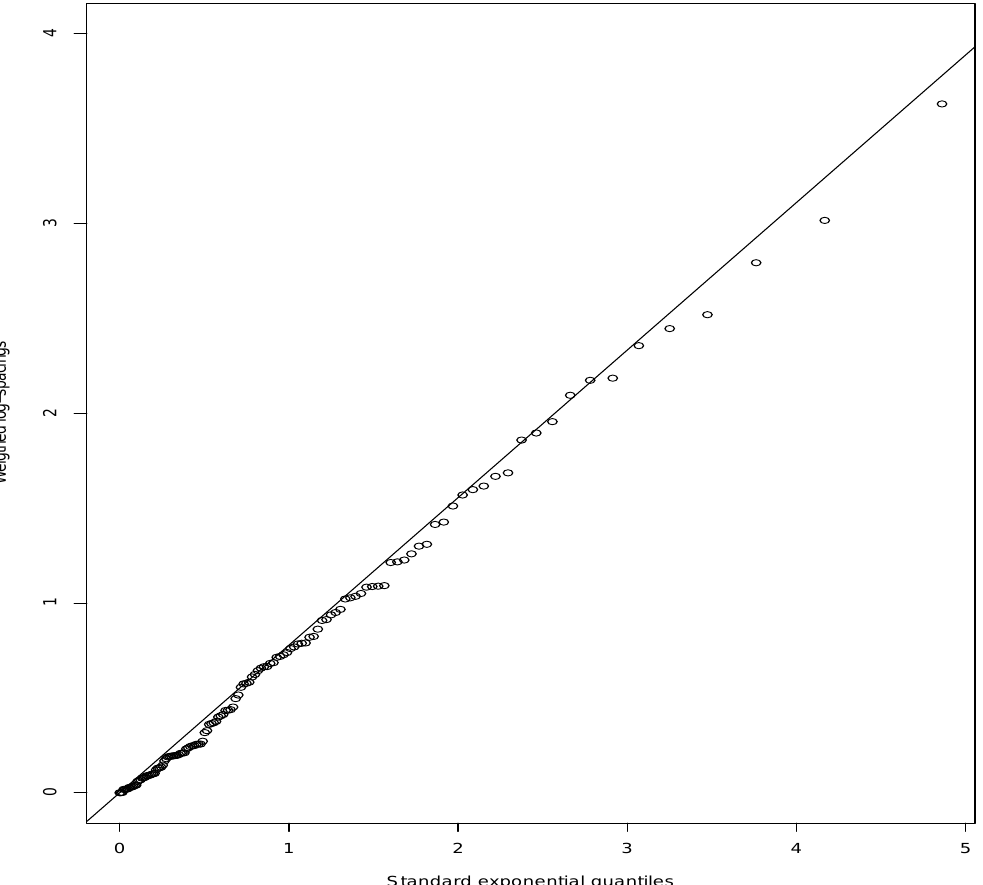
Figure 5: Illustration on motorcycle insurance data, quantile-quantile plot. Horizontally: Standard exponential quantiles, verti- cally: Weighted log-spacings computed on the residuals. The continuous line has slope ˆ γ